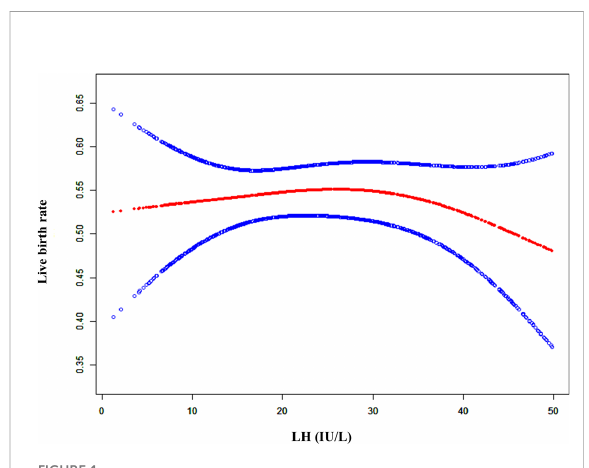
FIGURE 1 A smooth fi tting curve analysis of the relationship between LH levels on the hCG day and the live birth rates. The live birth rate of the patients decreased as the LH level on the hCG day gradually increased when the LH level was beyond a certain